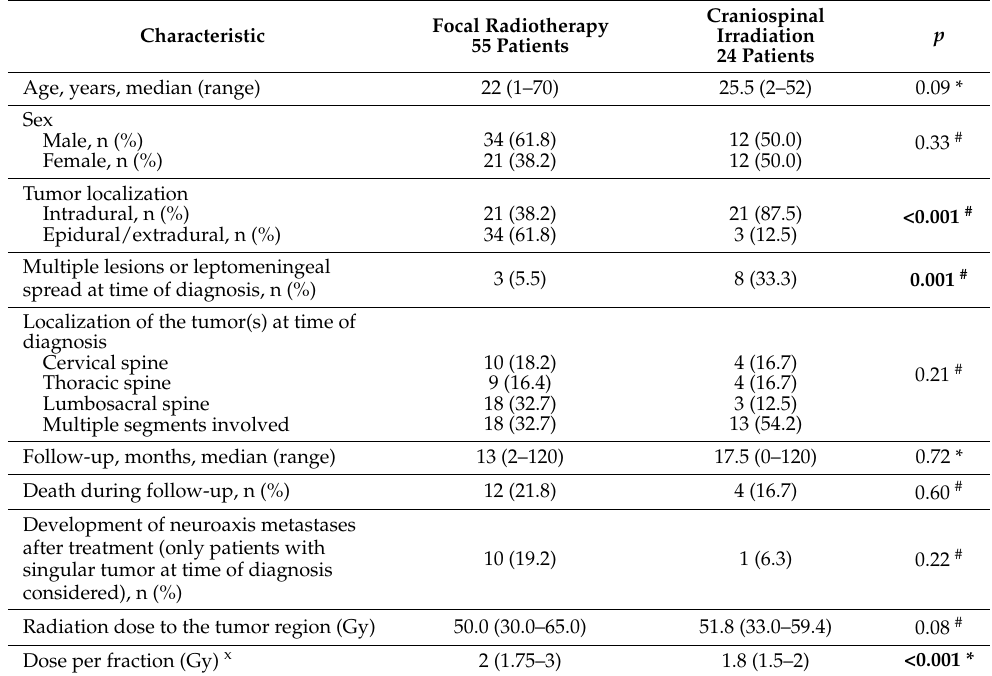
Table 2. Patient characteristics of the focal radiotherapy group, compared to the craniospinal irradia- tion (CSI) group. Mean (standard deviation), median (range) or n (%) is displayed, as appropriate. Not all information was available for all patients.